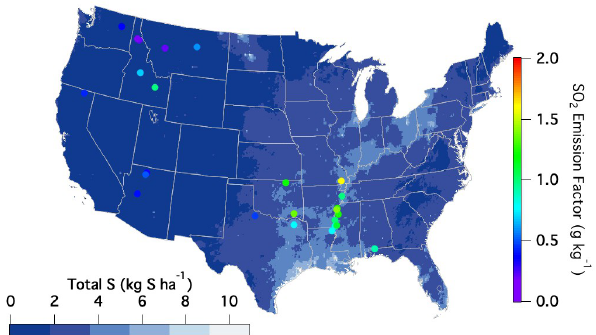
Figure 5. National Atmospheric Deposition Program (2022) reported sulfur deposition rates (https://nadp.slh.wisc.edu/ committees/tdep/#tdep-maps, last access: 1 May 2021) com- pared to SO 2 EFs (closed circles) by geographical location as measured during FIREX-AQ for all fuel